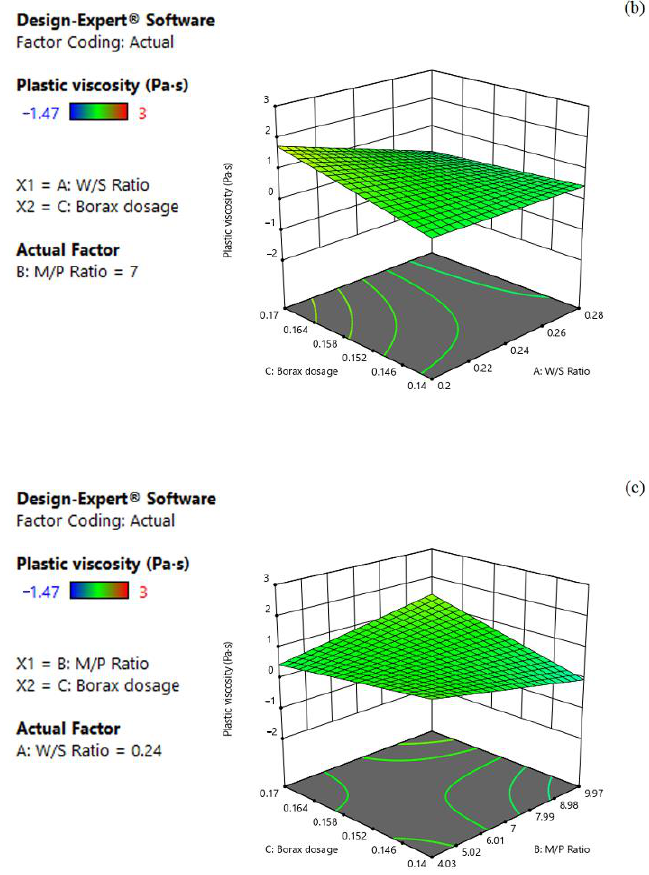
Figure 6. Three-dimension response surface plots of plastic viscosity (Y 4 ) in relation to: ( a ) W/S ratio (X 1 ) and M/P ratio (X 2 ); ( b ) W/S ratio (X 1 ) and borax dosage (X 3 ); ( c ) M/P ratio (X 2 ) and borax dosage (X 3 ).